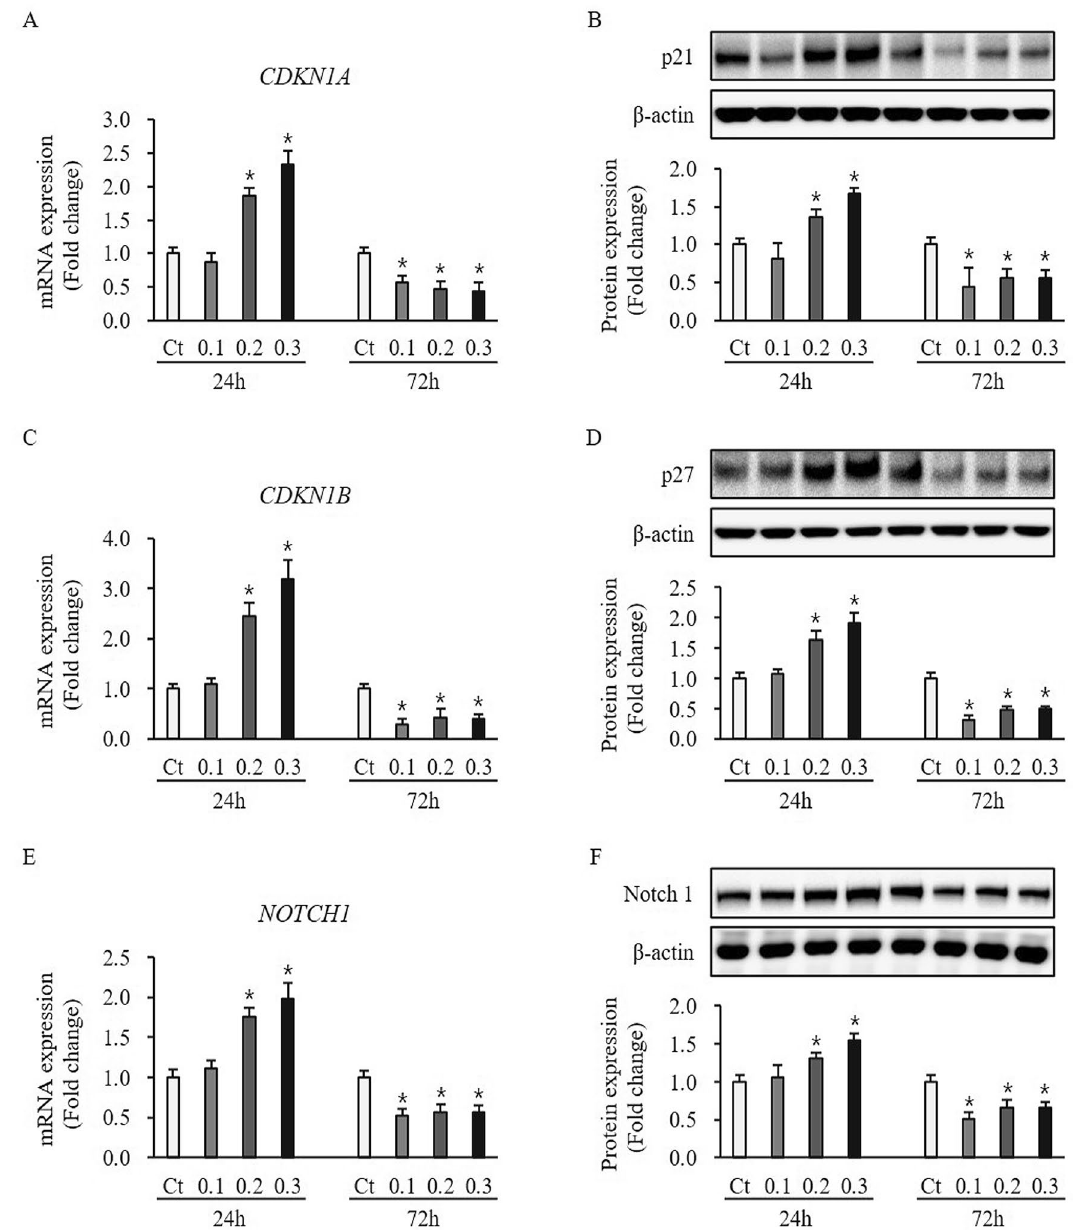
Figure 8. Expression of proliferation/differentiation regulators in HTSKs after ESWT. Significantly increased mRNA levels of genes encoding p21 ( CDKN1A ) (A) , p27 ( CDKN1B ) (C) , and Notch 1 ( NOTCH1 ) (E) in HTSKs at 24 h after ESWT under 0.2 and 0.3 mJ/mm 2 of energy flux density, compared with those in untreated control. Significantly decreased mRNA levels of genes encoding p21 (CDKN1A) (A) , p27 (CDKN1B) (C) , and Notch 1 (NOTCH1) (E) in HTSKs at 72 h after ESWT under 0.1, 0.2, and 0.3 mJ/mm 2 of energy flux density, compared with those in untreated control. Significantly increased protein levels of p21 (B) , p27 (D) , and Notch 1 (F) in HTSKs at 24 h after ESWT under 0.2 and 0.3 mJ/mm 2 of energy flux density, compared with those in untreated control. Significantly decreased protein levels of p21 (B) , p27 (D) , and Notch 1 (F) in HTSKs at 72 h after ESWT, compared with those in untreated control. In the fold change, untreated control cells marked as value 1; Ct, untreated control cells; HTSK, hypertrophic scar keratinocyte; * P < 0.05 for ESWT-treated cells vs. the corresponding matched untreated control cells. Data represent means ± SD; n =